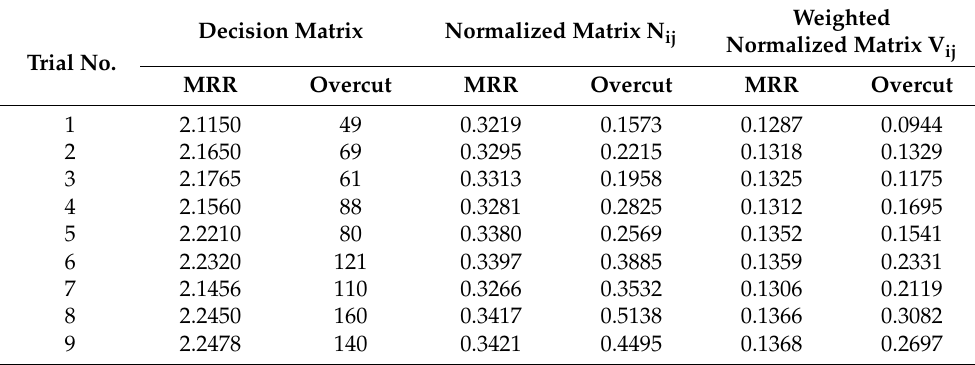
Table 3. Representation of decision matrix, normalized matrix and weighted normalized matrix for TOPSIS